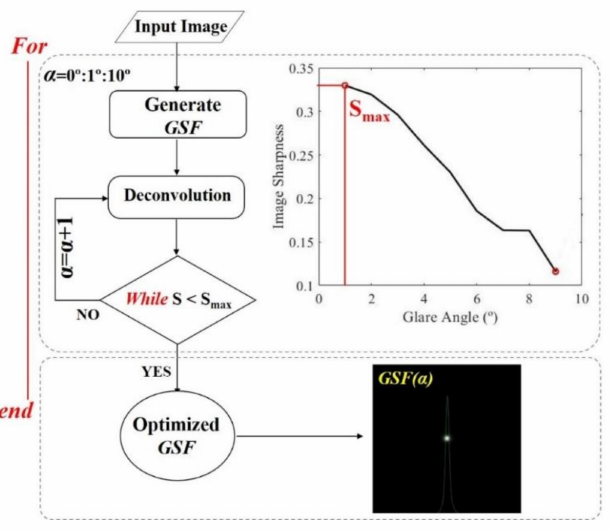
Figure 4. Step #1 of the algorithm.